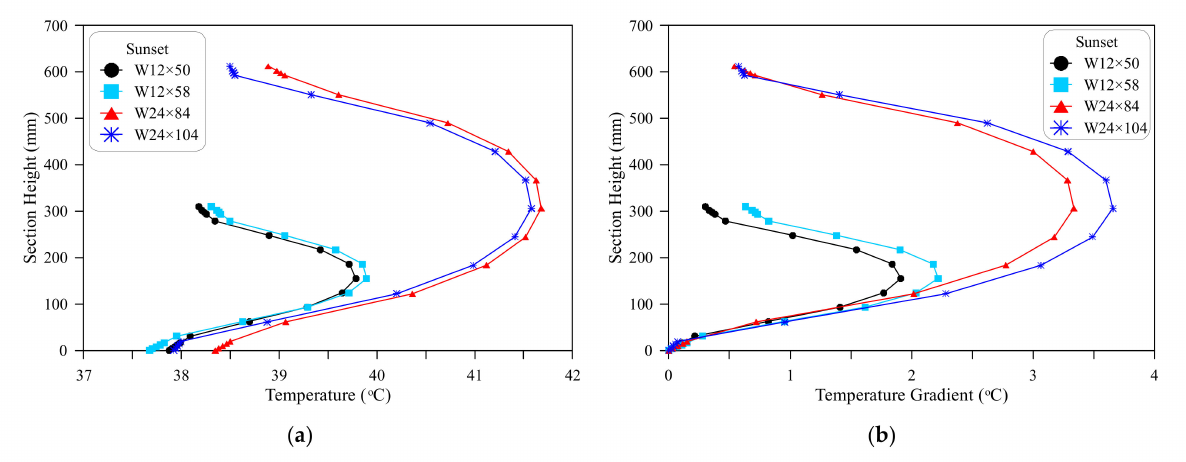
Figure 15. Vertical temperature distributions and temperature gradients at sunset: ( a ) Temperature distributions; ( b ) Temperature